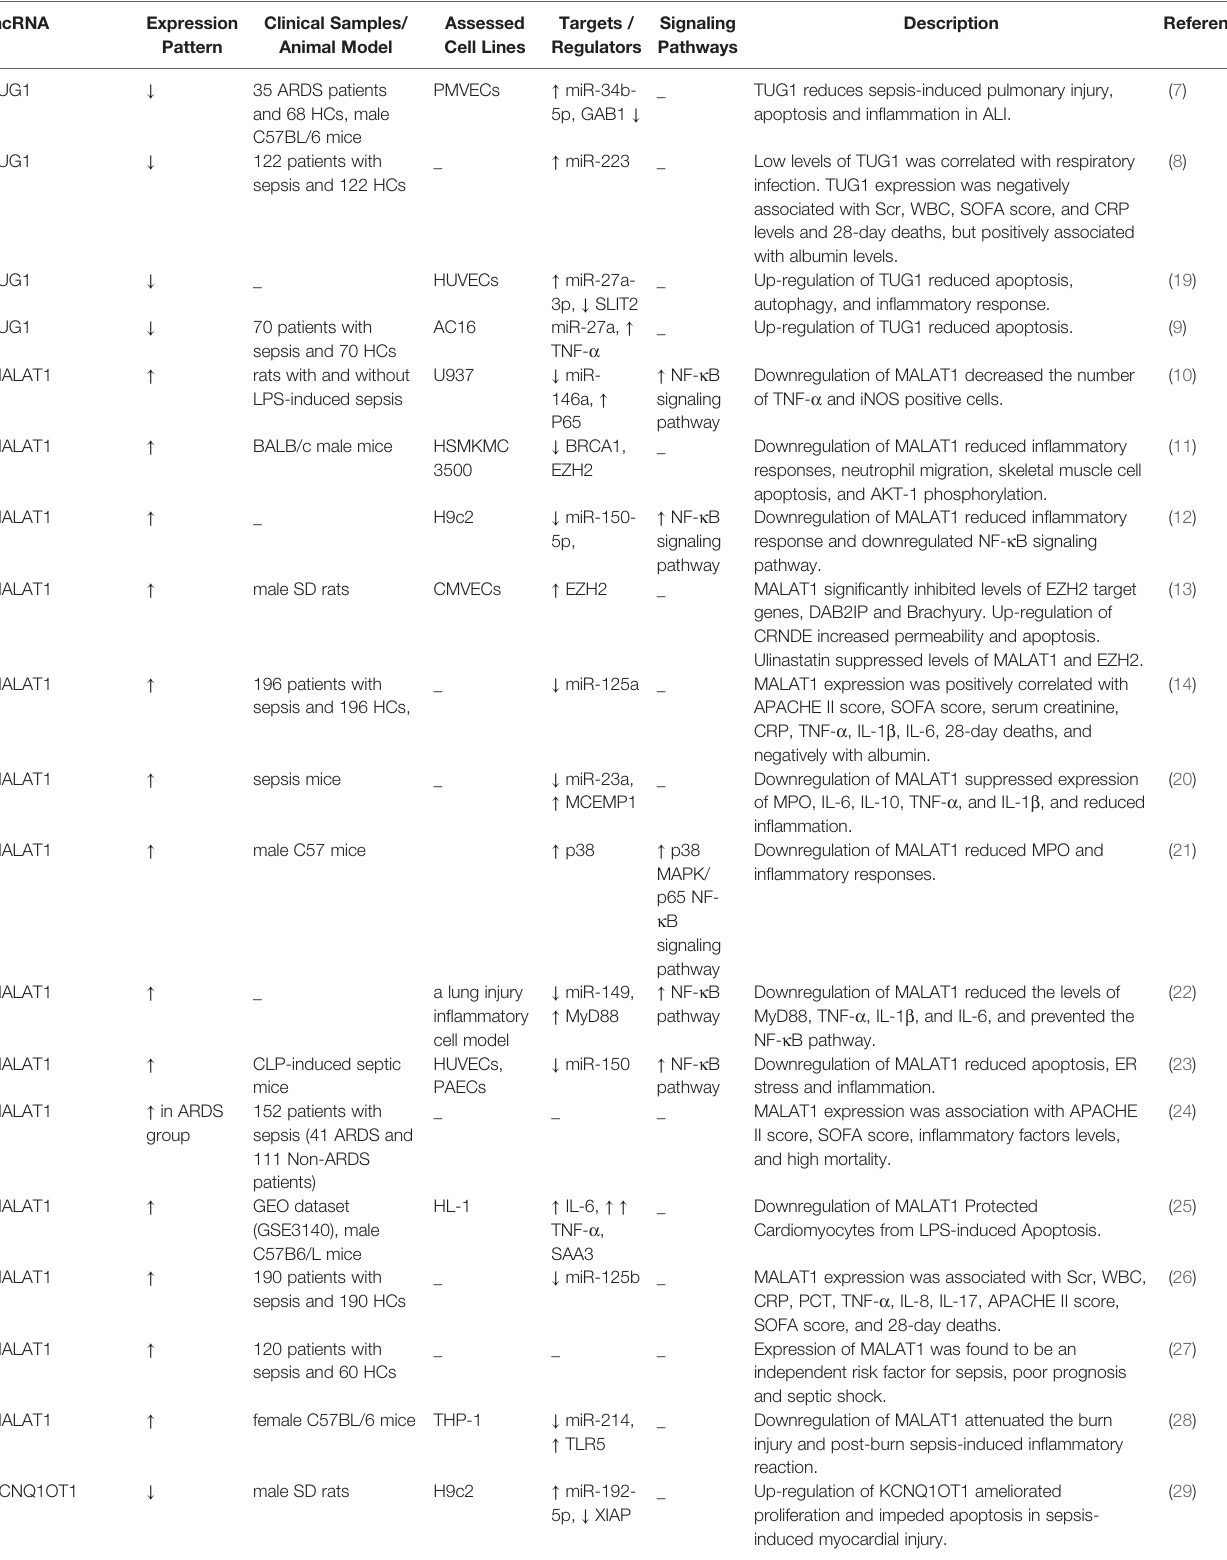
TABLE 1 | LncRNAs and